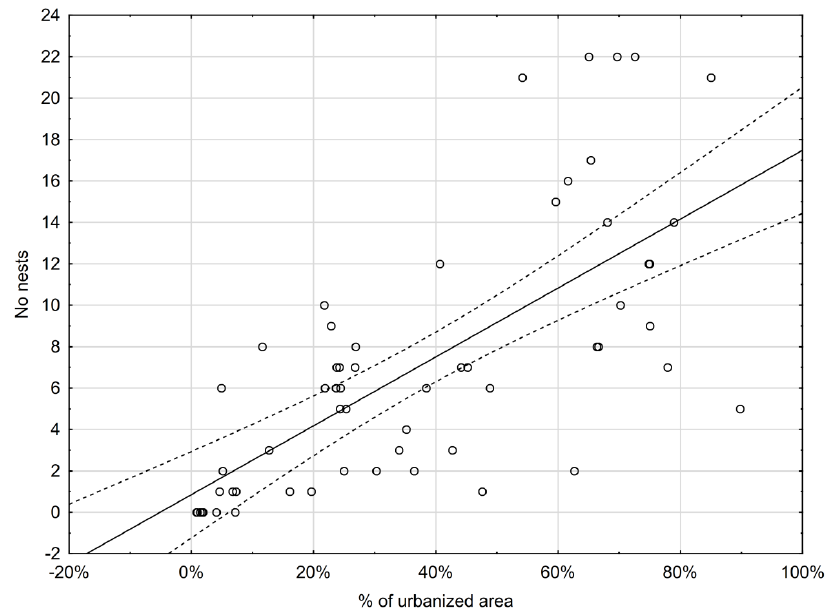
Figure 2. Correlation of Magpie nest density and degree of urbanization in Gorzów Wlkp. (r